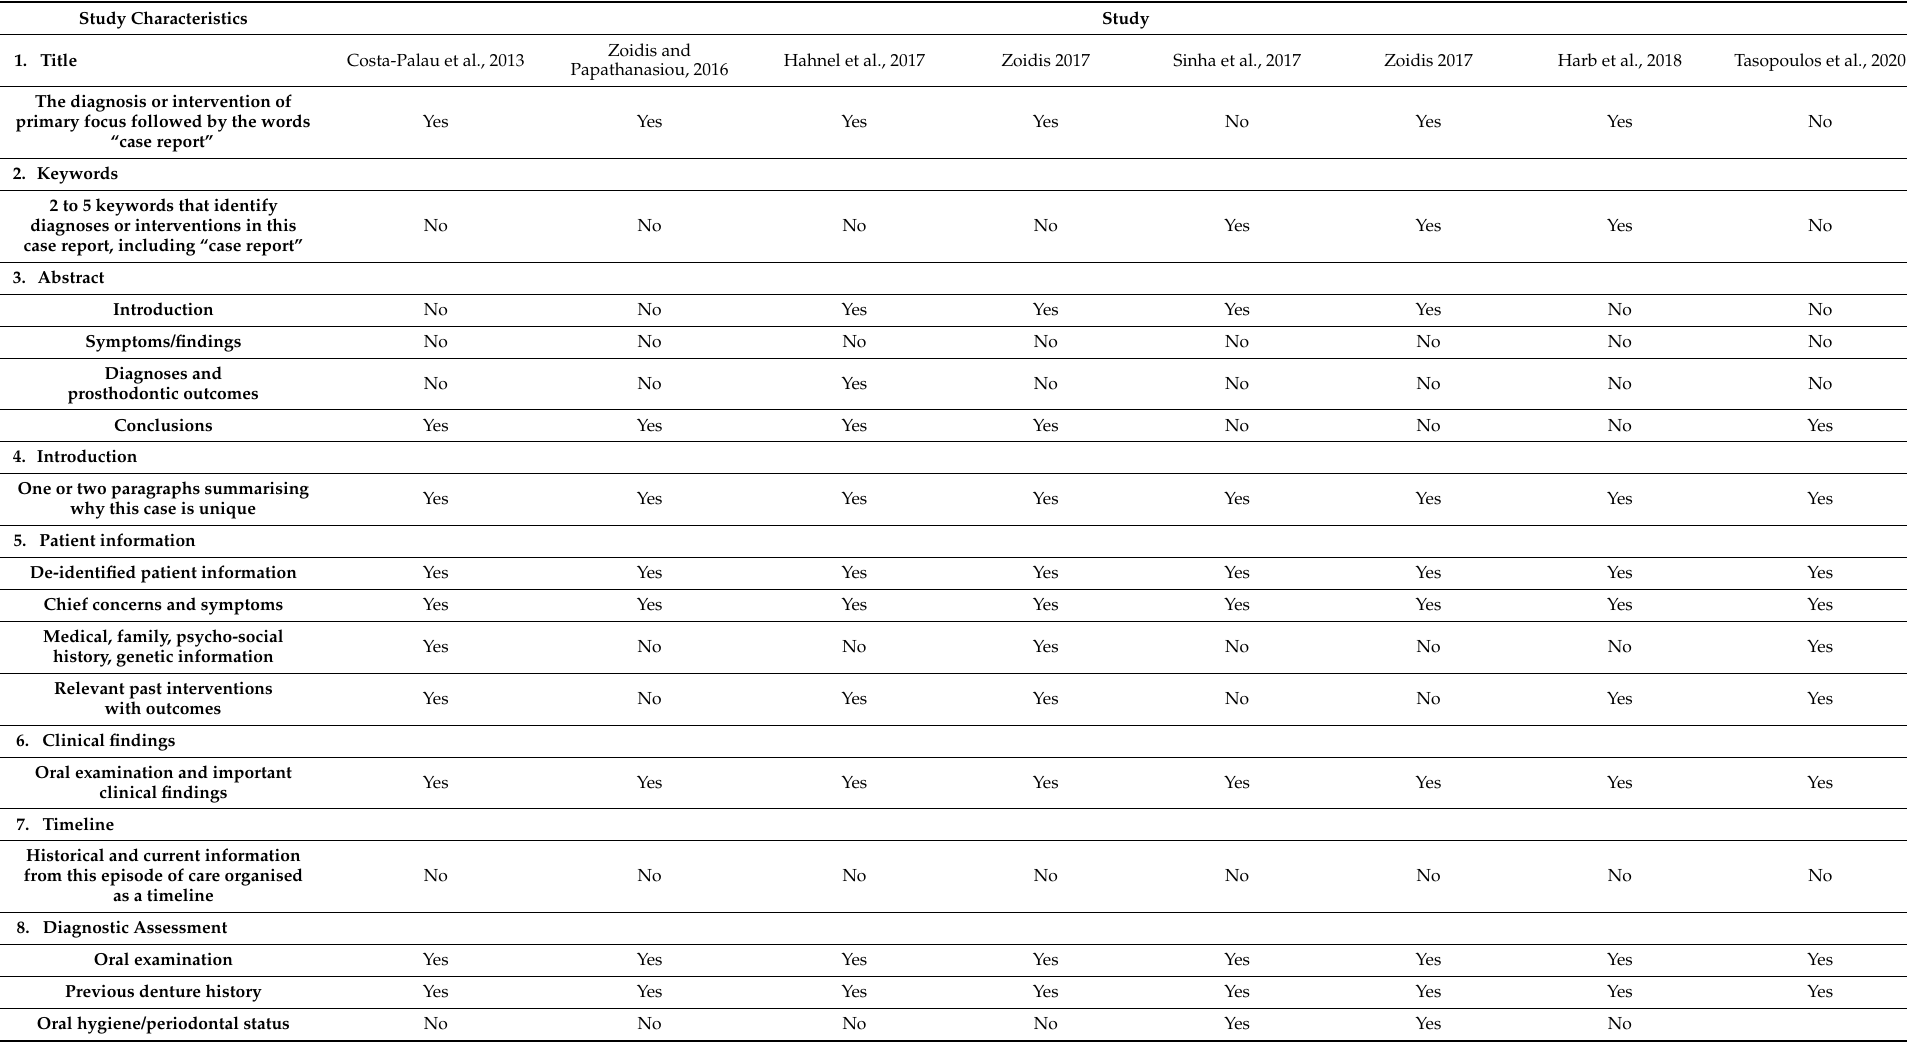
Table 4. Quality assessment results of the case reports included in this